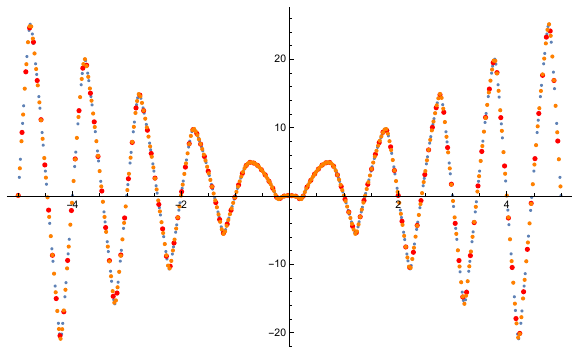
(cid:12) (cid:12) Q (cid:12) (cid:12) Figure 10 . The numerical plots of log (cid:0) e ( z I ( u ( (cid:29) )); (cid:28); (cid:28) )(cid:0) e ( z I ( (cid:0) u ( (cid:29) )); (cid:28); (cid:28) ) as a function (cid:12) (cid:12) I of (cid:29) 2 R , for (cid:28) = 1 + 2 i and u ( (cid:29) ) = (cid:29) (cid:28) . The blue points are obtained by using the product representation (2.15) with (cid:15) = 0 : 2. We have truncated this representation at level j + k = 30, where the indices j and k are the mute ones in the product (2.15). The orange points are obtained by using (C.29) for m = 2, n = 0, (cid:15) = 0 : 2. We truncate this series at level j = 30, where the index j is the mute one in the (2 ; 0) representation (C.29). The red points are obtained by using the representation (C.29) with m = 1, n = 0, and (cid:15) = 0 : 2. We truncate this series at level j = 30, where the index j is the mute one in the (1 ; 0) representation